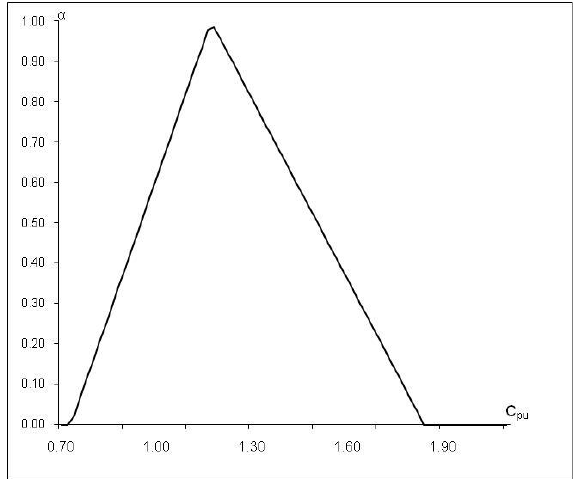
Fig. 9. The membership function of the index for